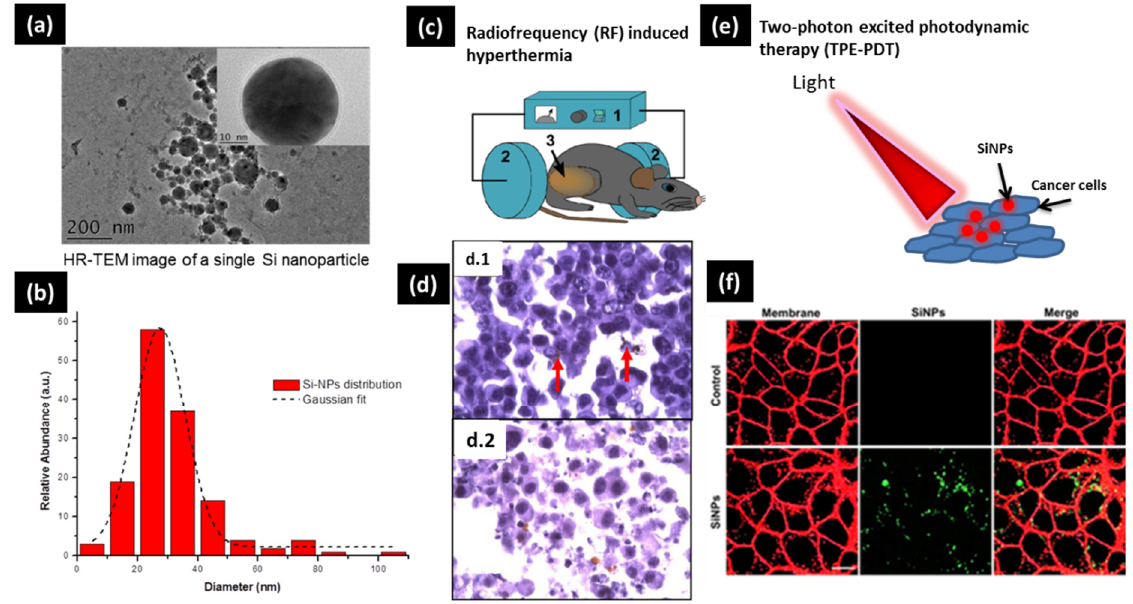
Figure 2. ( a ) Typical HR-TEM (High-resolution transmission electron microscopy) image of SiNPs produced by pulsed laser ablation in liquid (PLAL) with corresponding diameter size distribution ( b ). ( c ) Schematics of the RF (Radio frequency) radiation-based therapy setup with inhibition tumor effect after 1 h (d.1) and 3 days (d.2) of RF-based treatment using SiNPs as nano-sensitizers ( d ). ( e ) A schematic drawing of the principle of two-photon excited photodynamic therapy. ( f ) Confocal microscopy imaging of inhibition effect of SiNPs on living cells MCF-7 breast cancer after two-photon excited photodynamic therapy treatment at 900 nm. ( a ) and ( b ) are adapted from Reference [83], ( c ) and ( d ) are adapted from Reference [81], ( e ) and ( f ) are adapted from Reference